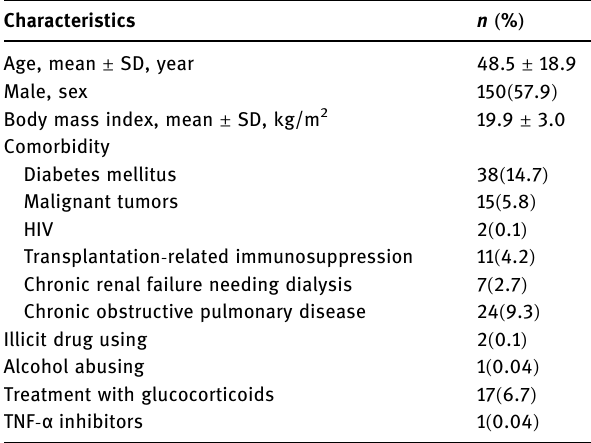
Table 1: General characteristics of patients with atypical pulmonary tuberculosis mimicking pneumonia Characteristics